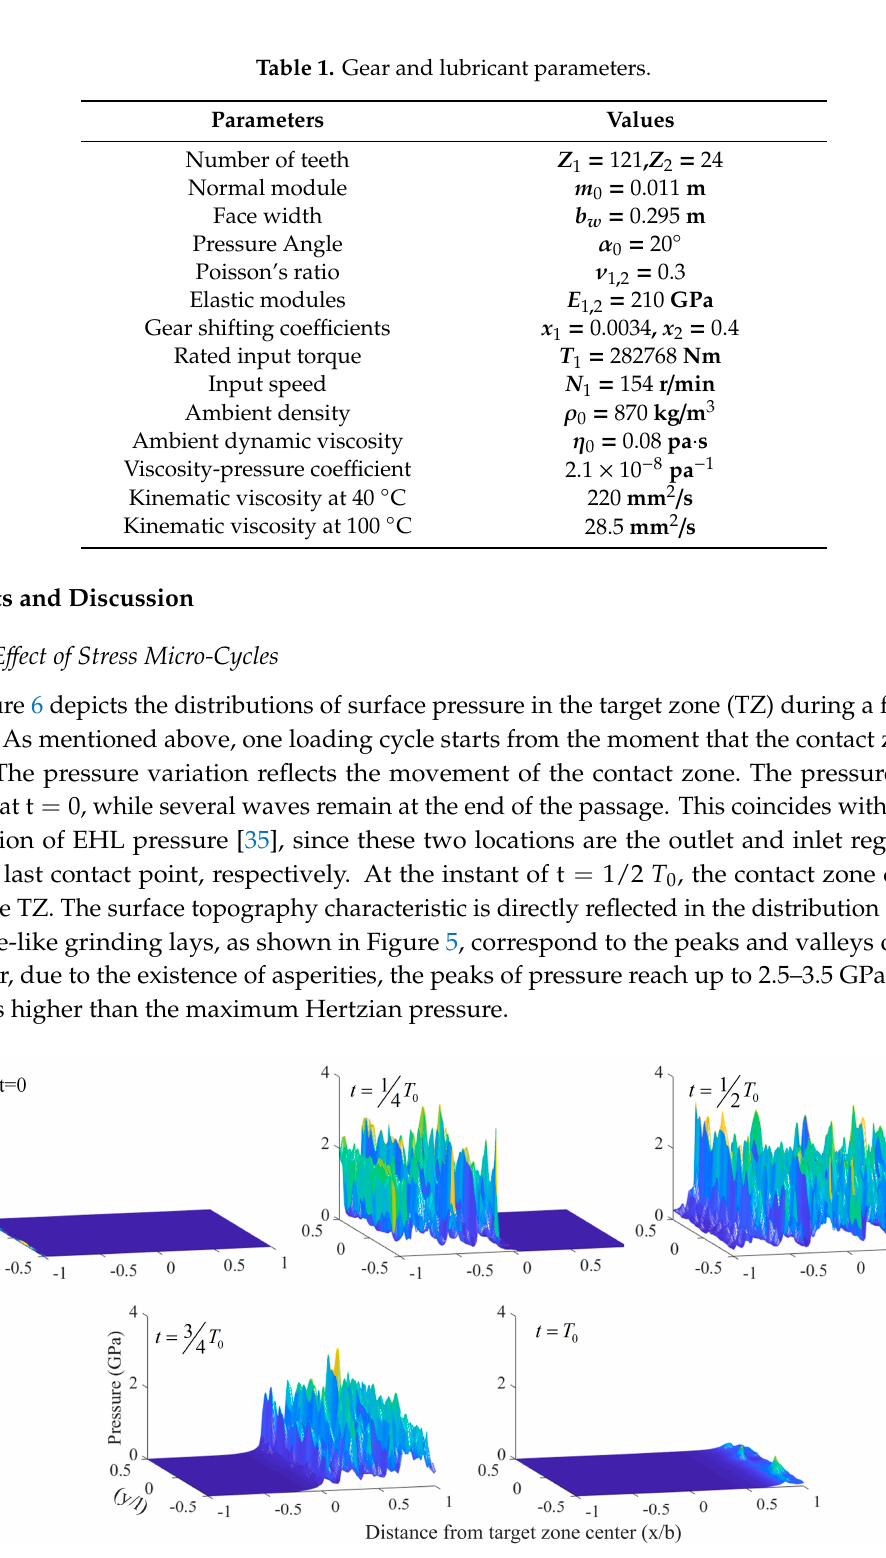
Table 1. Gear and lubricant parameters.